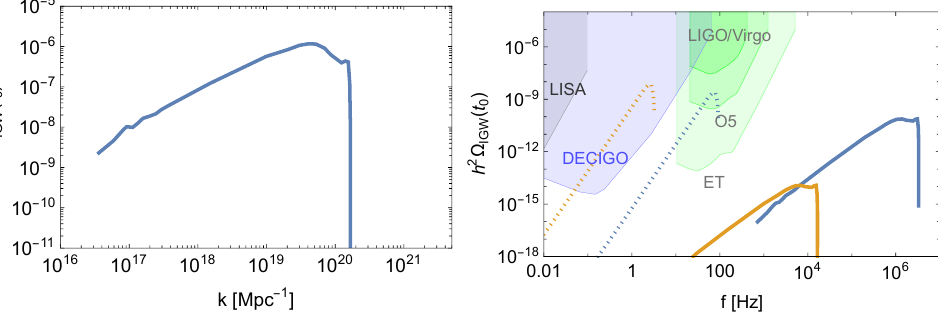
Figure 5. In the left panel the early spectrum of induced GWs is depicted, produced during a kination domination phase by a monochromatic P R ( k ) and associated with PBHs with mass M PBH = 10 5 g. In the right panel the present day frequency spectrum is depicted for M PBH = 10 5 g (blue curve) and M PBH = 10 8 g (orange curve) and for β ∼ 10 − 10 . Note the change of the shape of induced GW spectrum due to kination and early matter domination phase. The dotted curves depict the corresponding isocurvature-induced GWs, adopted from Ref. [96]. The colored areas are enclosed by the sensitivity curves of LIGO/Virgo, Einstein Telescope, LISA and DECIGO.